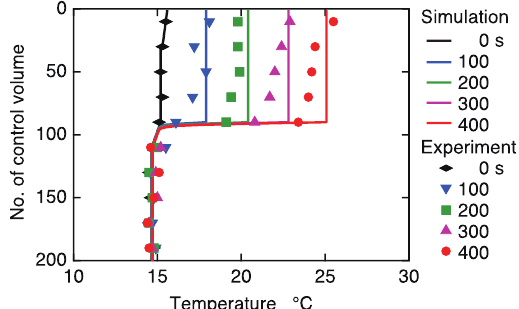
Figure 4. Experimental and simulated results in case A.